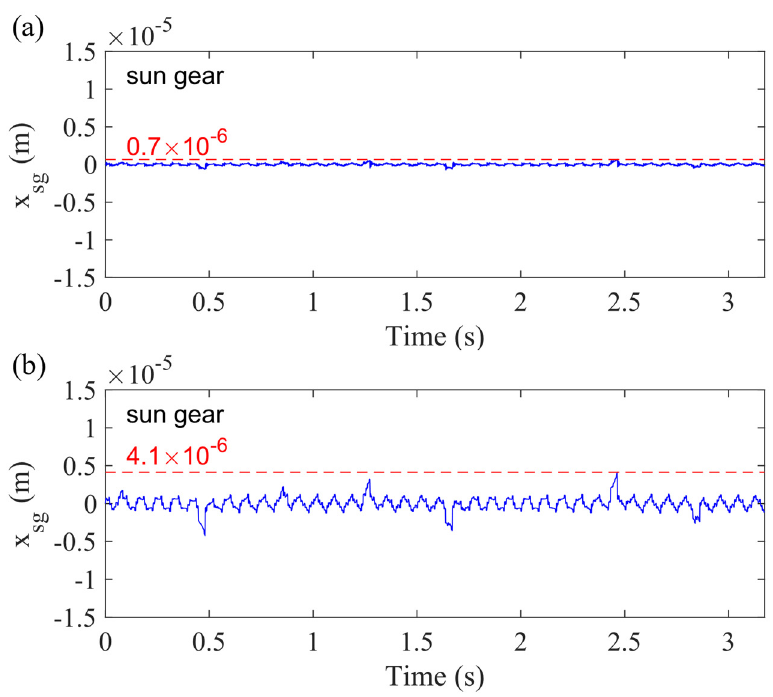
Figure 18. Vibration response of sun gear with 50% sun gear crack level for ( a ) Case 1 and ( b ) Case 5 in x g